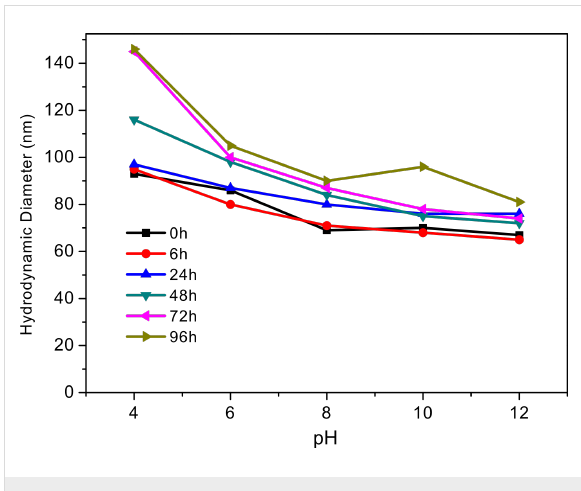
Figure 9: Hydrodynamic diameter measured by DLS for F127-CdS/ ZnS QDs at different pH values.